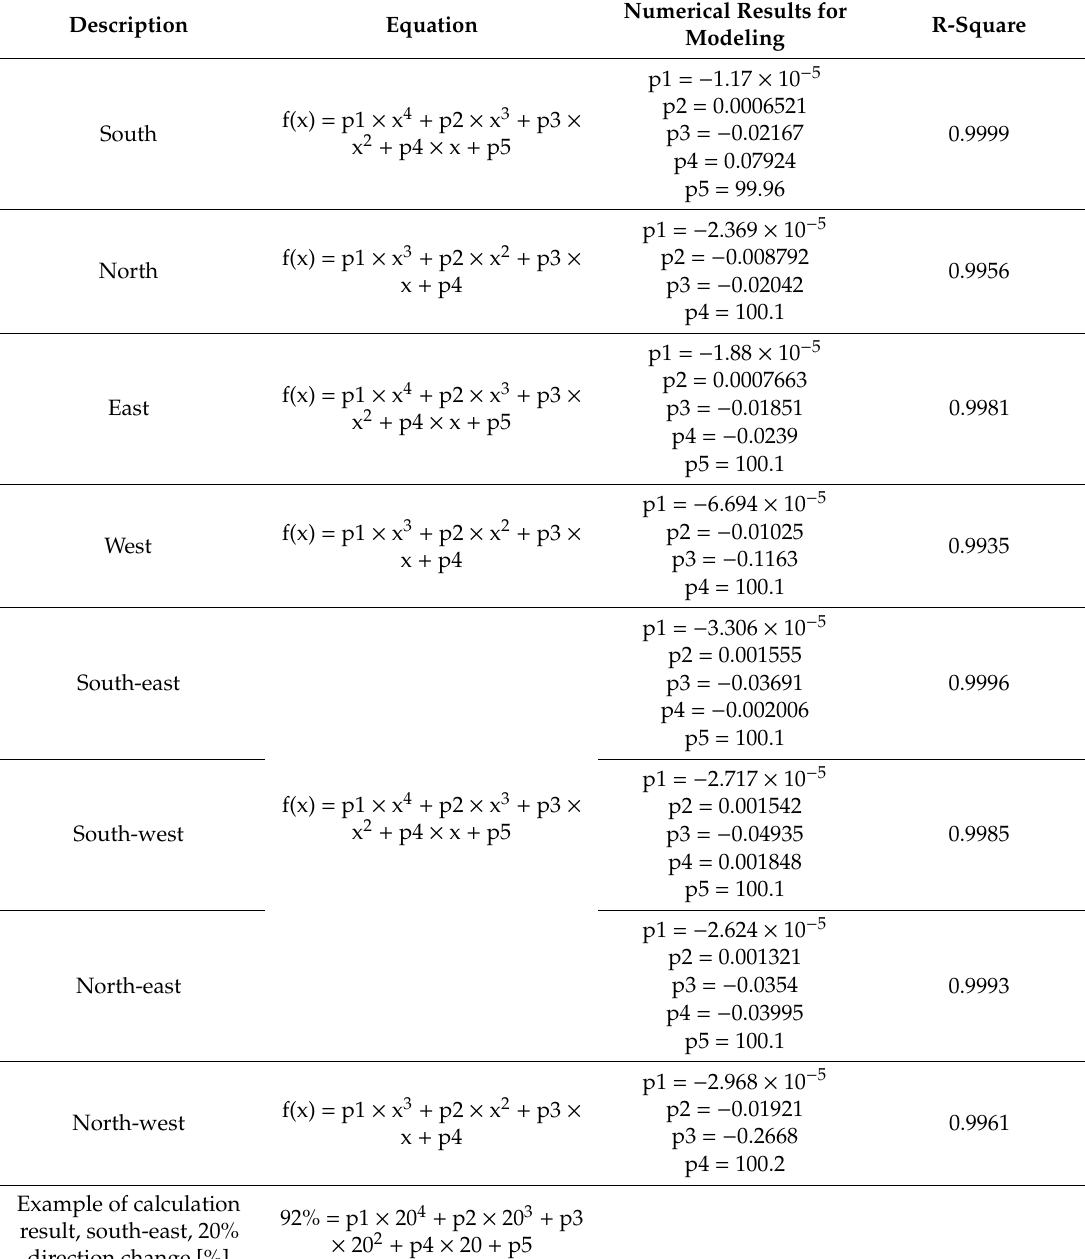
Table 7. The e ff ect of directional changes on p-Si performance (x = change in orientation ( ◦ ); f(x) = percentage value of the performance compared to the